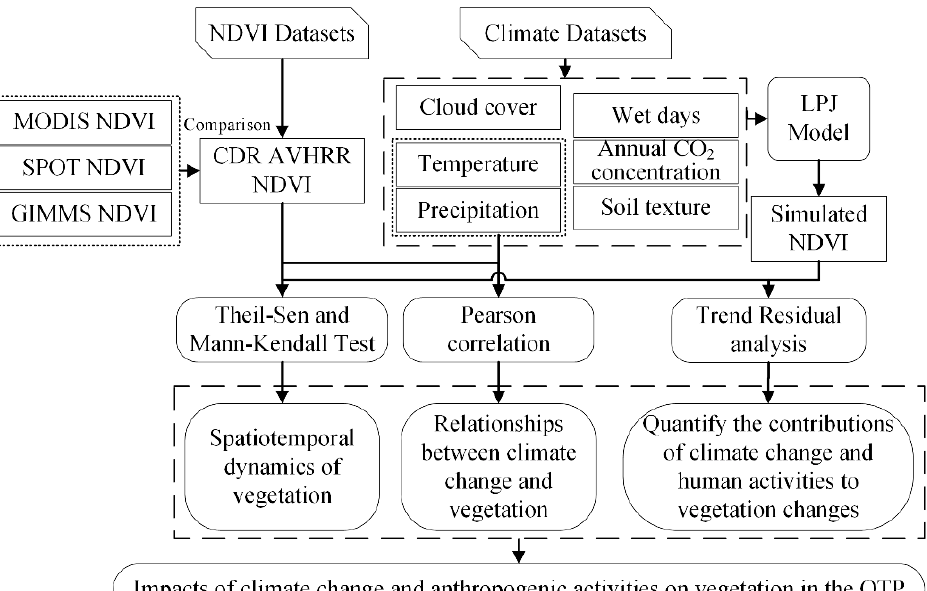
Figure 2. Methodological framework of this study.